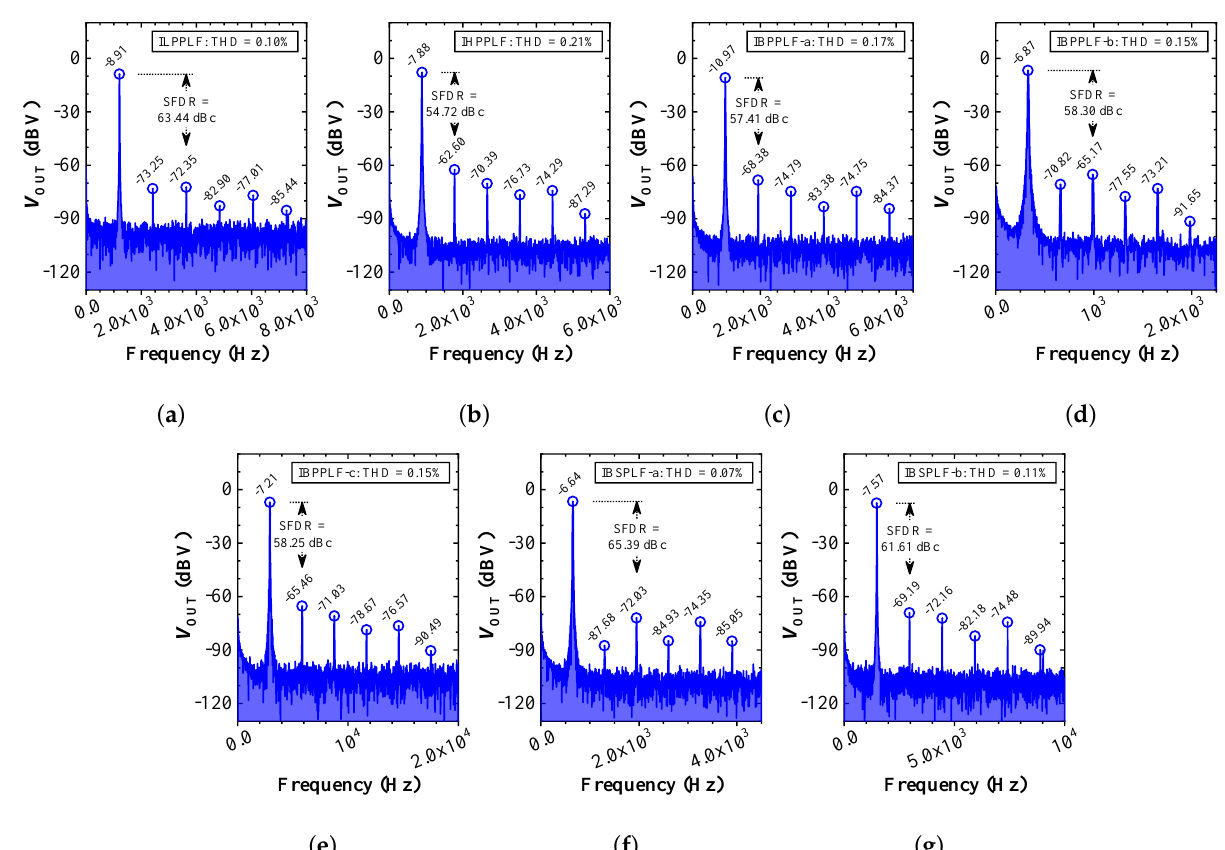
Figure 19. FFT spectrums (experimental) of the proposed inverse filters ( α = 0.5) pertaining to the ( a ) ILPPLF, ( b ) IHPPLF, ( c ) IBPPLF-a, ( d ) IBPPLF-b, ( e ) IBPPLF-c, ( f ) IBSPLF-a, and ( g )